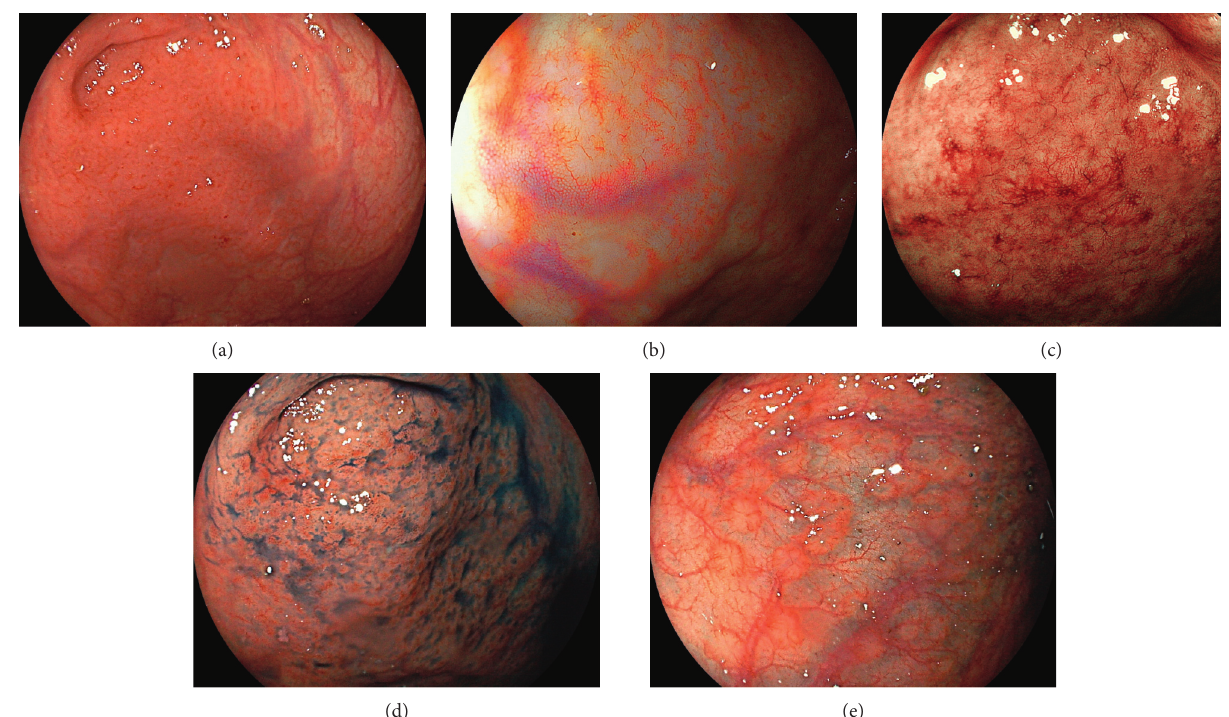
Figure 4: Colonoscopy images of the cecum. A reddish flat elevated lesion is seen (a). Magnified linked color imaging image shows elongated microvessels (b). Partial disappearance of the pit structure and elongated microvessels are observed in the narrow-band imaging image (c). Indigo carmine spraying reveals that the areas with no pit structures are slightly depressed (d). Papular lesions resembling lymphoid follicles are observed in the cecum and ascending colon (e). Although we initially considered this lesion to be involved with the MALT lymphoma, the final diagnosis was appendiceal orifice inflammation in ulcerative colitis.